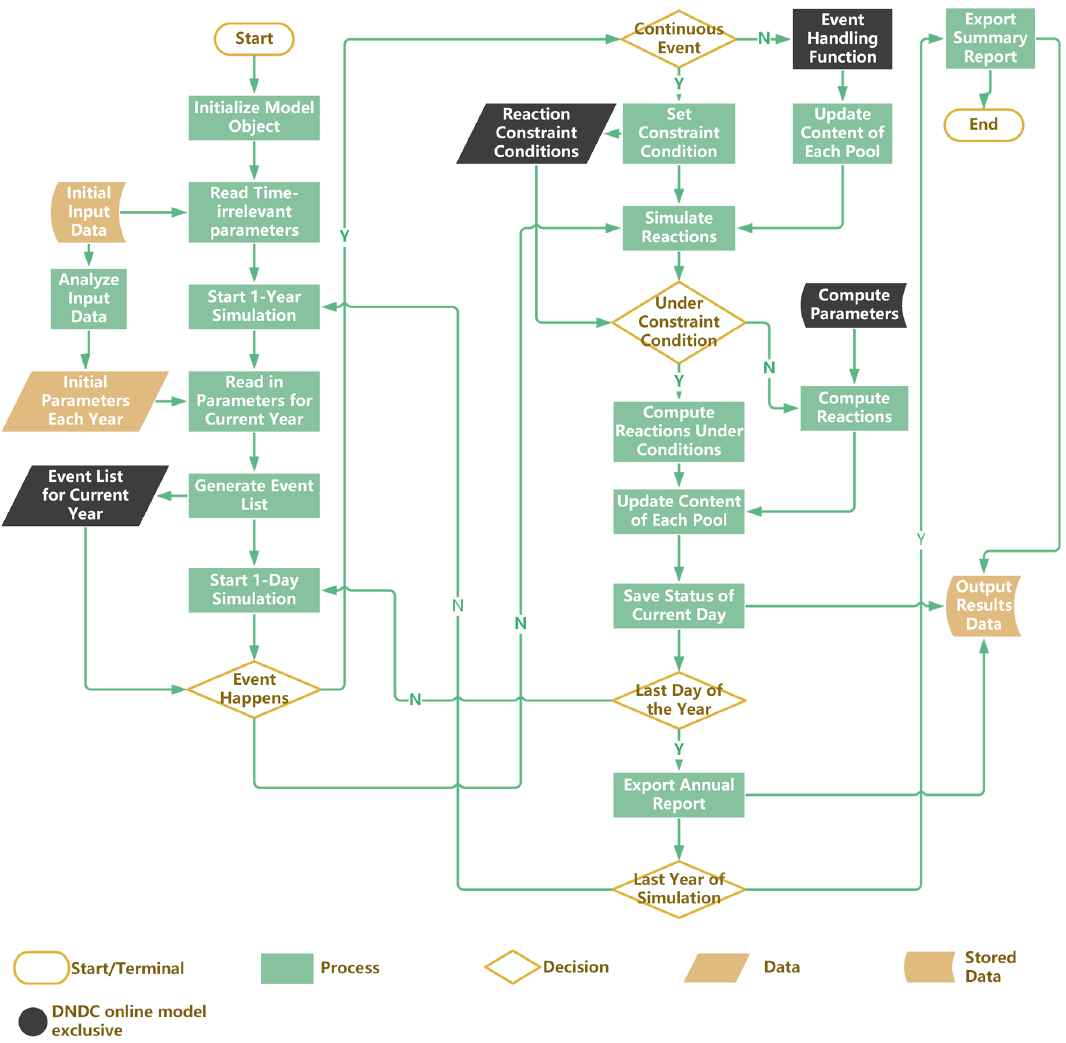
Figure 2. Abridged procedure flowchart of the DNDC online model simulation program.